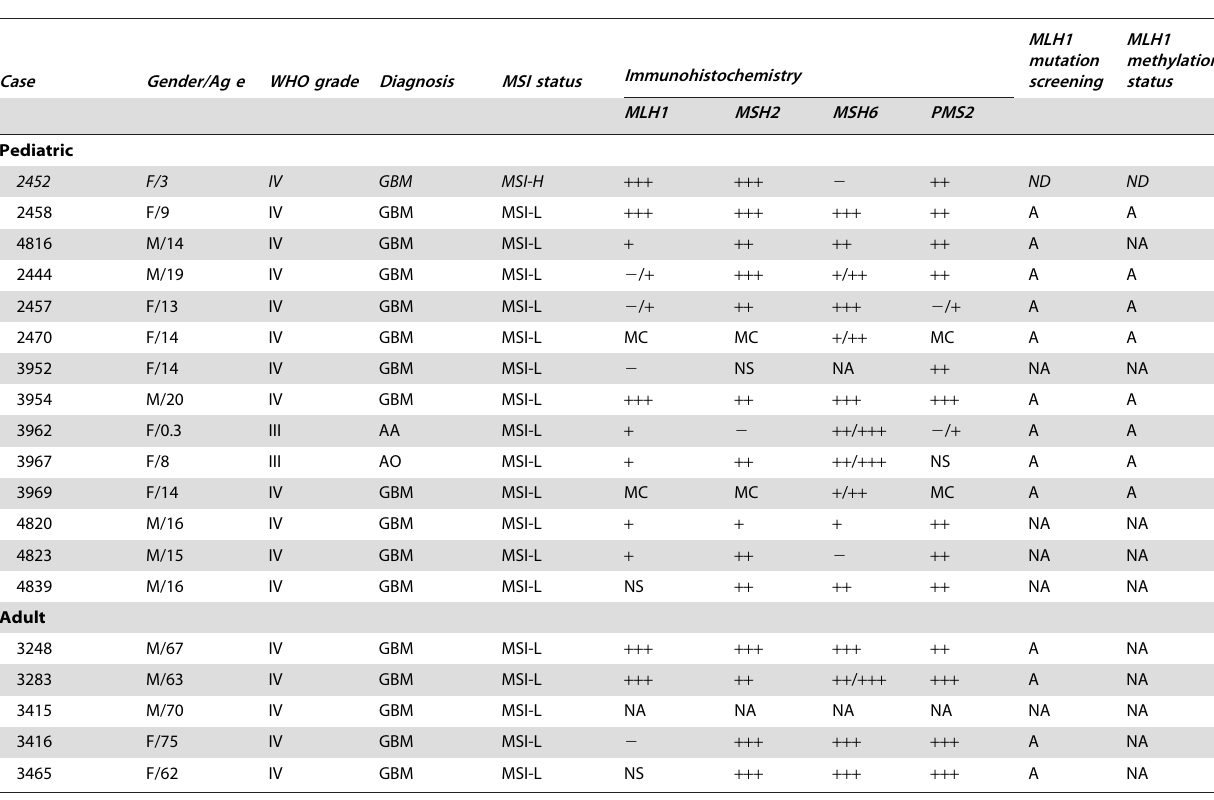
Figure 1. Microsatellite instability in pediatric HGG. Representative electropherogram traces for three MSI-positive pediatric HGG, presenting sequence alterations in more than one quasimonomorphic marker. Case RMH2452 (MSI-H) presented alterations in NR27, NR21, BAT25 and BAT26; RMH2458 (MSI-L) in NR21 and BAT25; and RMH4816 (MSI-L) in NR21 and NR24. Alterations in relation to a control trace are indicated with arrows. doi:10.1371/journal.pone.0020588.g001 normal function of the protein, a member of the MRE11-RAD50- NBS1 (MRN) complex involved in DNA repair. As models we used three leukemia/lymphoma cell lines (Figure 4A): Daudi, MRE11 poly(T)11/12; Raji, MRE11 poly(T)11/11, wild type, and DNA repair proficient; and Jurkat, MRE11 poly(T)10/11 known to generate alternative splicing in exon 5 of MRE11 (Figure 4B) and DNA repair deficient [26]. The presence of an aberrant Table 1. Clinical characterization and MMR status of MSI